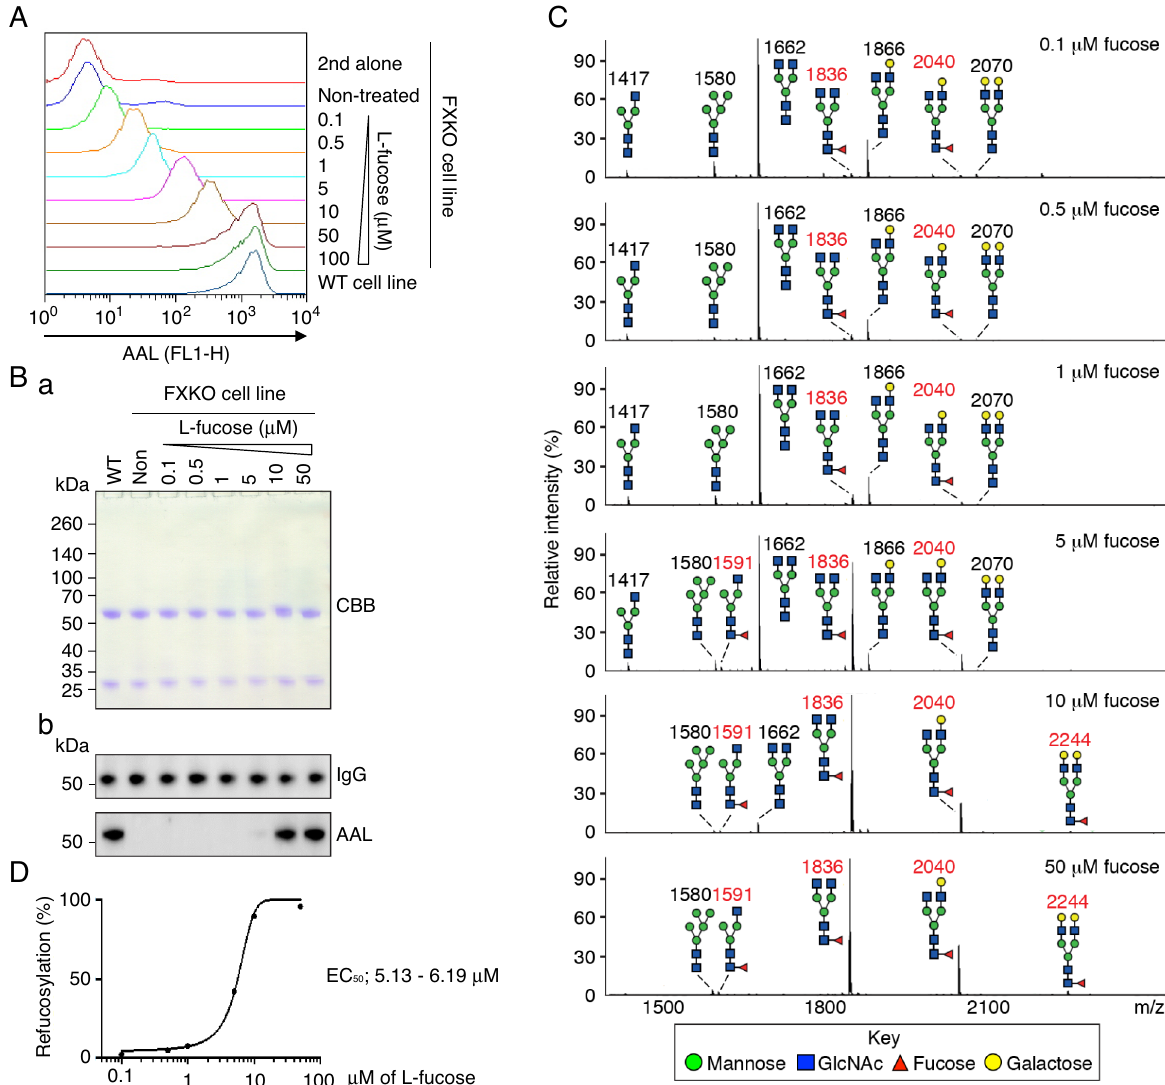
Figure 2. Refucosylation of anti-Tn mAb in FXKO cell line via salvage pathway. ( A ) Remab6-expressing FXKO cells fed with different concentration of L-fucose (starting at 0.1 μM) for 4 days in culture, and analyzed refucosylation levels by flow cytometry with AAL; Remab6-expressing WT transfectant used as a control. One representative of two independent experiments (n = 2). (B) A series of Remab6 produced by cells used in ( A ) analyzed by CBB on SDS-PAGE gel ( a ), or Western and lectin blots with human IgG or AAL ( b ). Remab6 from WT was used as a control. One representative of three independent experiments (n = 3). (C) A series of Remab6 produced and characterized in ( A ) analyzed by MALDI-TOF–MS. The relative intensity of the most abundant peak in each spectrum is set as 100% (m/z 1662, 0.1–5 μM; m/z 1836, 10 or 50 μM), and selected peak masses were annotated to note structural features: fucosylated (red) and non-fucosylated glycans (black) (n = 1). ( D ) % of Refucosylation levels on Remab6 analyzed in ( C ). EC 50 calculated with Prism; see Table 1 for further